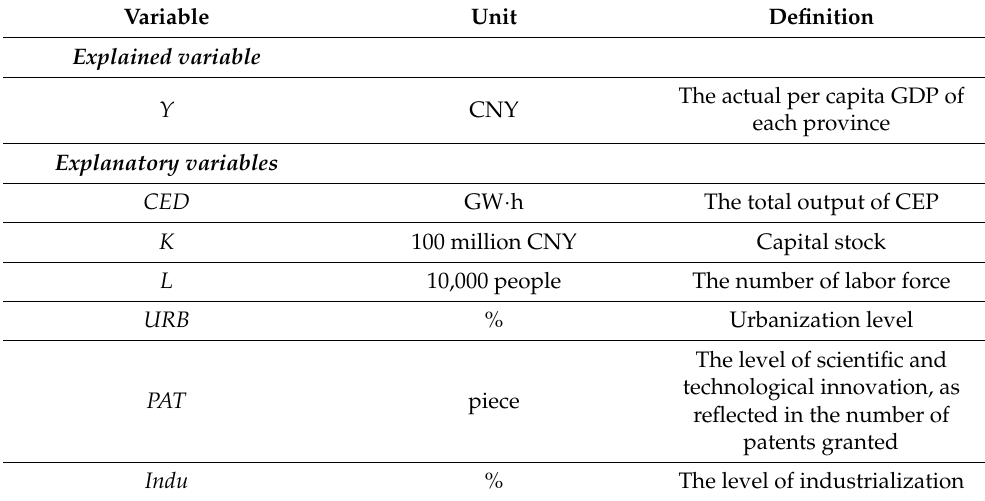
Table 1. Definition of the variables. Variable